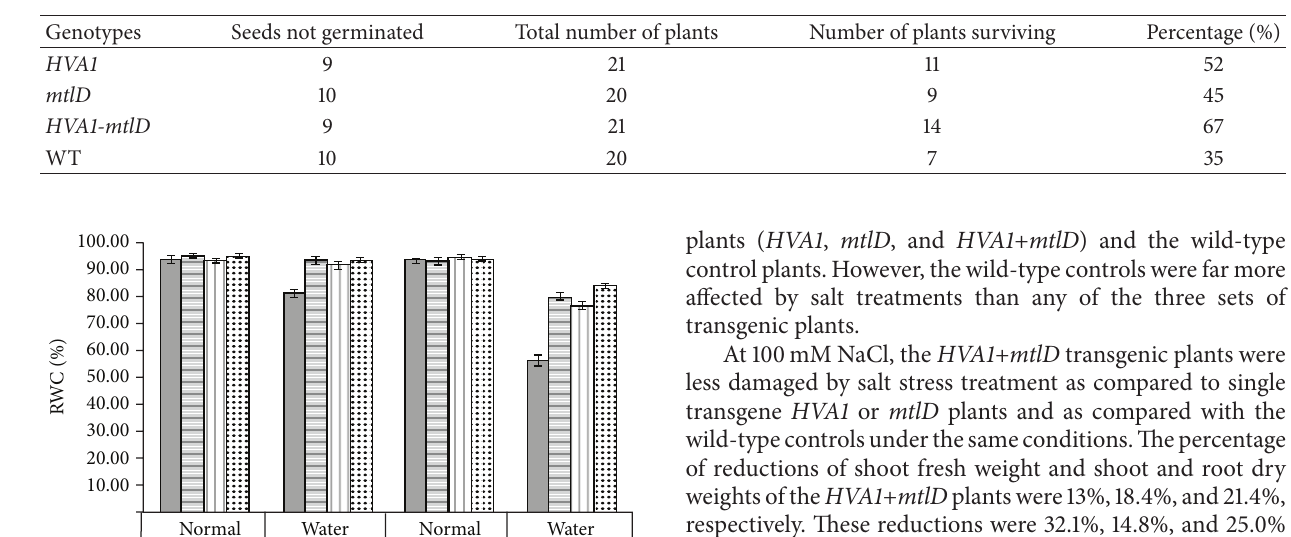
Table 1: Effect of drought tolerance on the percentage of survival of T3 lines versus wild-type control plants that were exposed to water deficit for 15 days followed by 7 days of recovery from water deficit.